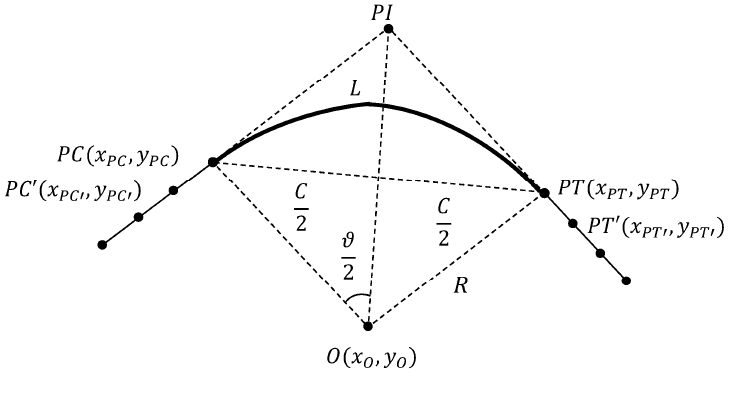
Figure 2. Curve parameters.